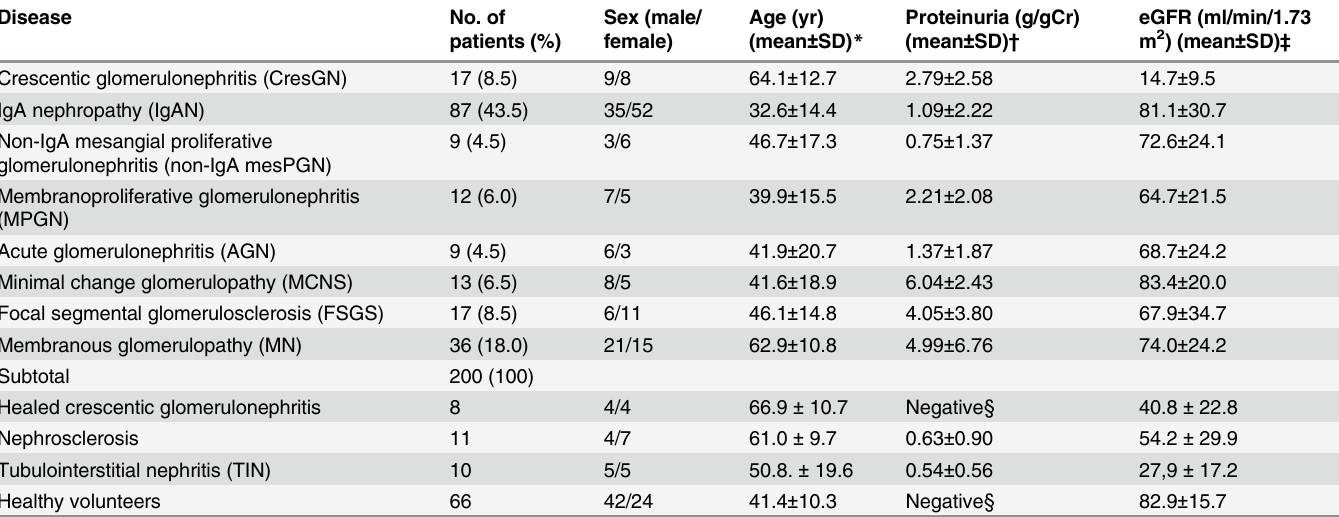
Table 1. Characteristics of the patients.